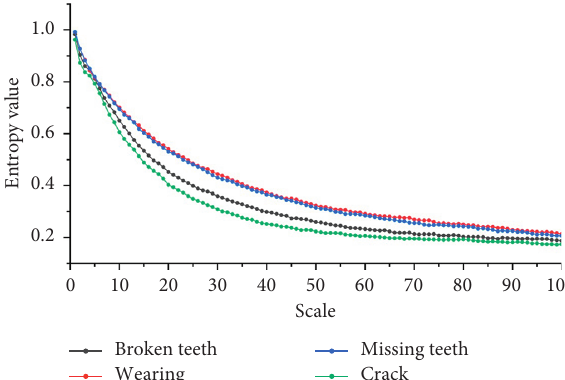
Figure 11: The calculated DCSMDE value of the signal after distributed compressed sensing varies with the scale.